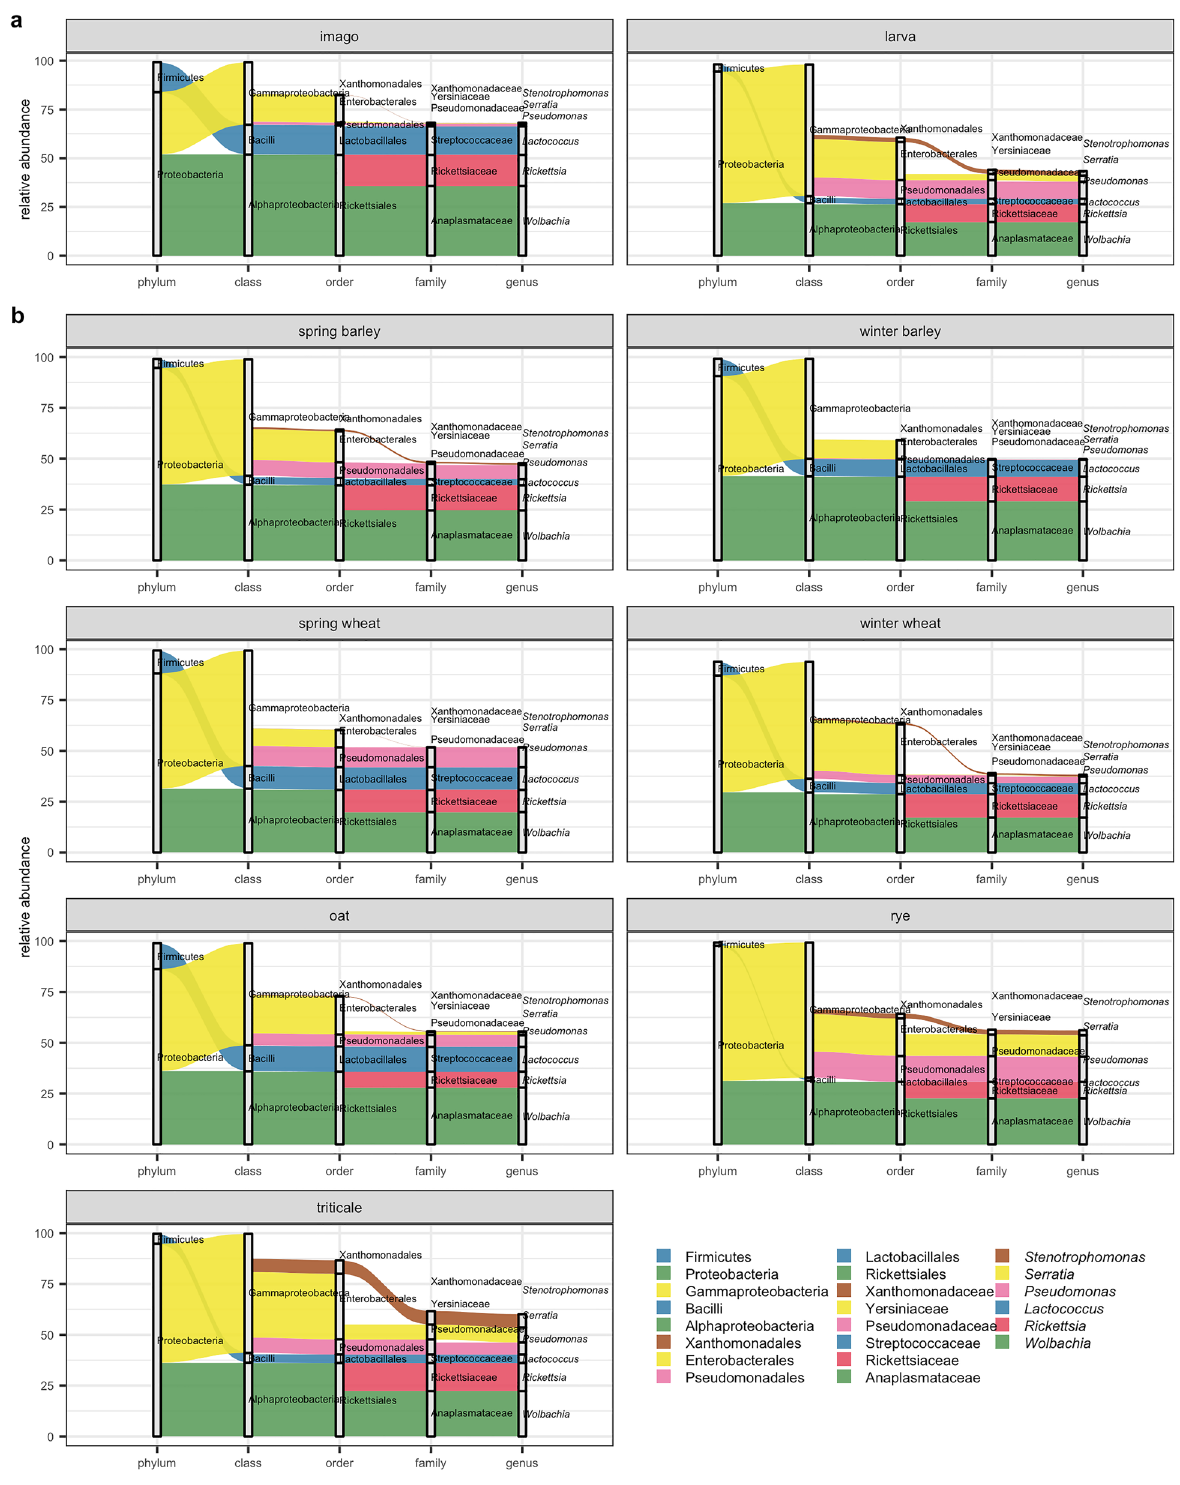
Figure 1. CLB-associated bacteria distribution at phylum, class, order, family, and genus level depending on the variable ( a ) insect’s developmental stage (imago, larva), ( b ) cereal host (spring barley, winter barley, spring wheat, winter wheat, oat, rye, and triticale). The rank taxa with the highest mean value of relative abundance for taxa from Top Biome on each taxonomic level are included in the